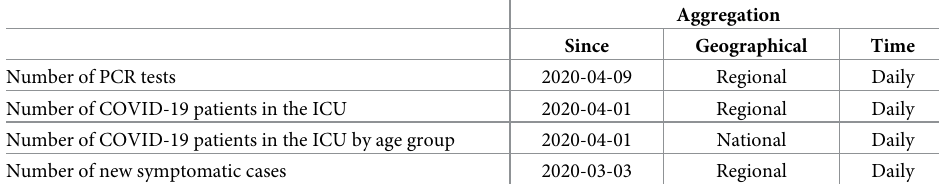
Table 1. Publicly available data used in the